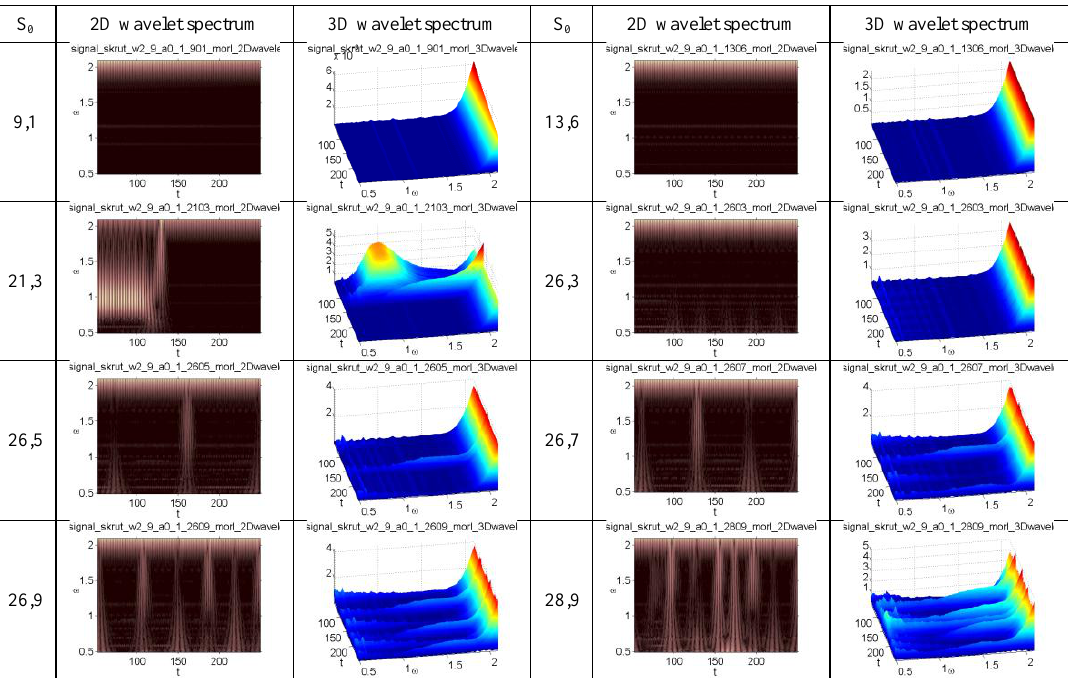
Transition from periodicity to chaos for a plate (ω p =